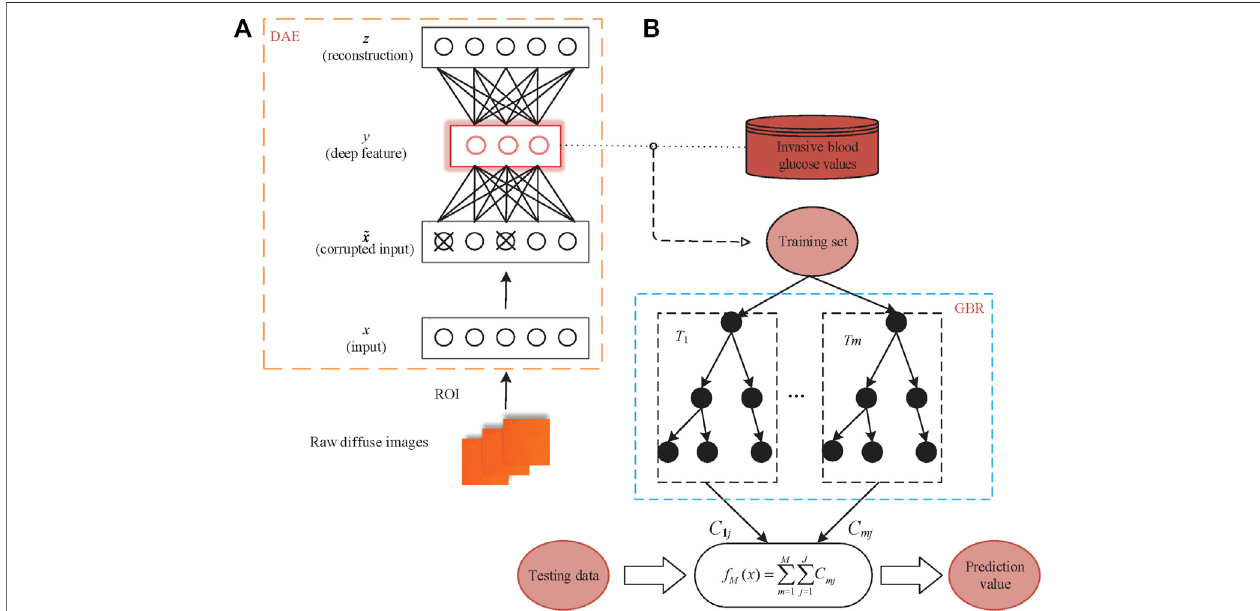
FIGURE 2 | Detailed network structure of the proposed algorithm (A) the DAE model; (B) the GBR model.